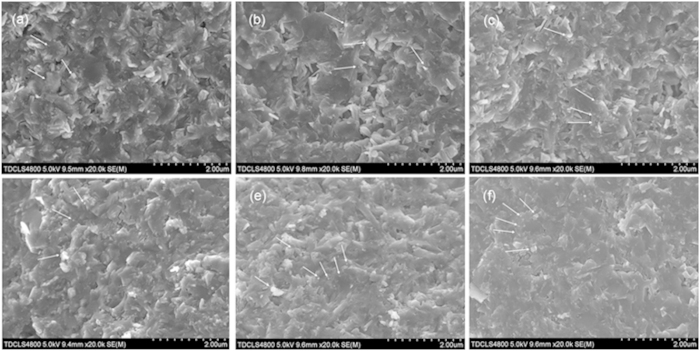
SEM images for the un-doped sintered for (a) 5 h, (b) 10 h, (c) 15 h, and the Cu-doped Mg11B2 samples sintered at (d) 5 h, (e) 10 h, (f) 15 h.